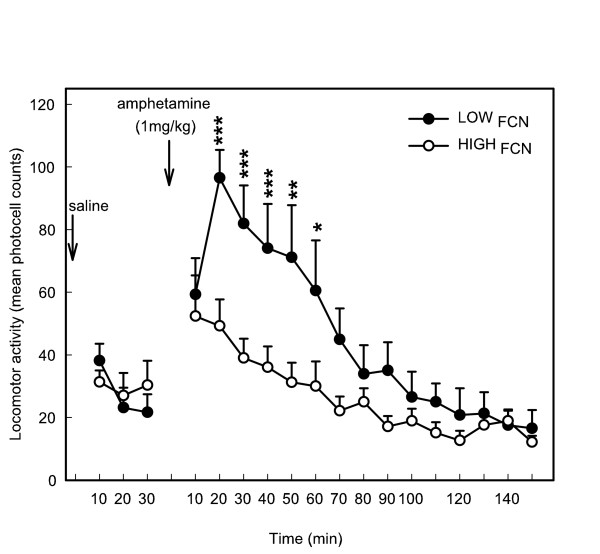
Comparisons of locomotor activity of rats with low (LOWFCN) and high levels of inhibition (HIGHFCN) selected in the FCN task in response to saline and amphetamine injections (1 mg/kg i.p.). LOWFCN had a higher locomotor response to amphetamine compared to HIGHFCNlasting 1 h after injection. LOWFCN locomotor activity returned to basal levels 70 min after amphetamine injection whereas it only returned to baseline after 40 min for HIGHFCN. ANOVA (NK): ***, p < .001; ** p < .01; * p < .05.